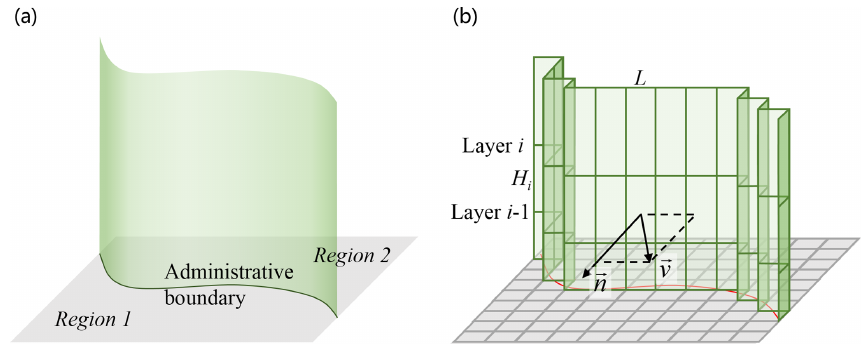
Figure 3. An example of the vertical surface for flux calculation (a) before discretization, and (b) after discretization.